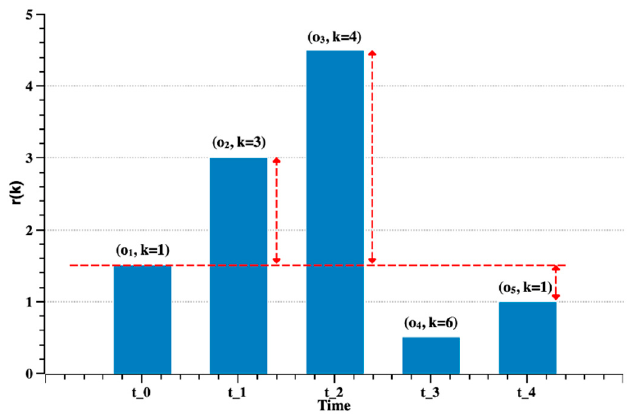
Figure 3. The description of (cid:1873) (cid:3036) ’s historical preferences.